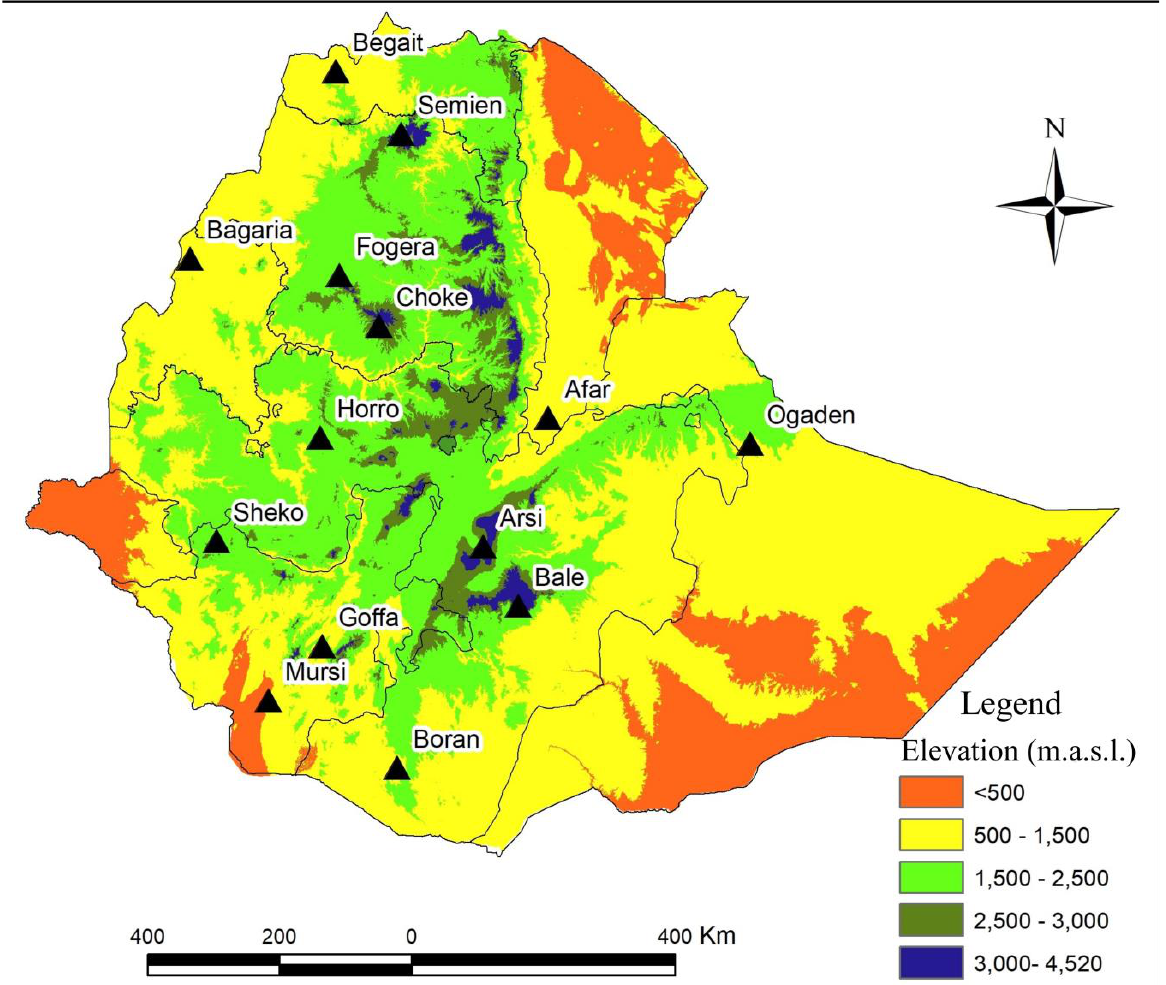
Figure 1. Geographical map of Ethiopia showing sampling locations of the cattle populations in relation to the agro-ecologies.